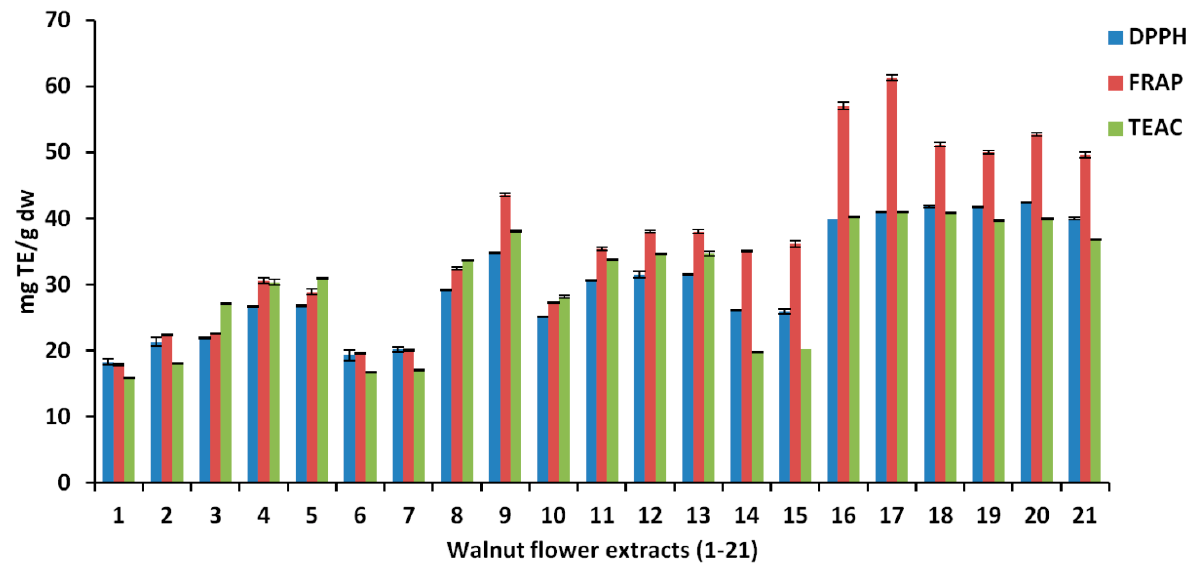
Figure 5. The antioxidant activity evaluated by DPPH, FRAP and TEAC assays for walnut flower extracts.